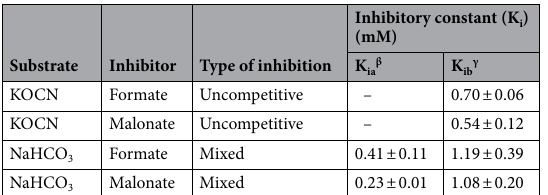
Table 3. Summary of inhibition kinetics of Tl-Cyn. β The K i for binding to the free enzyme. γ The K i for binding to the enzyme–substrate